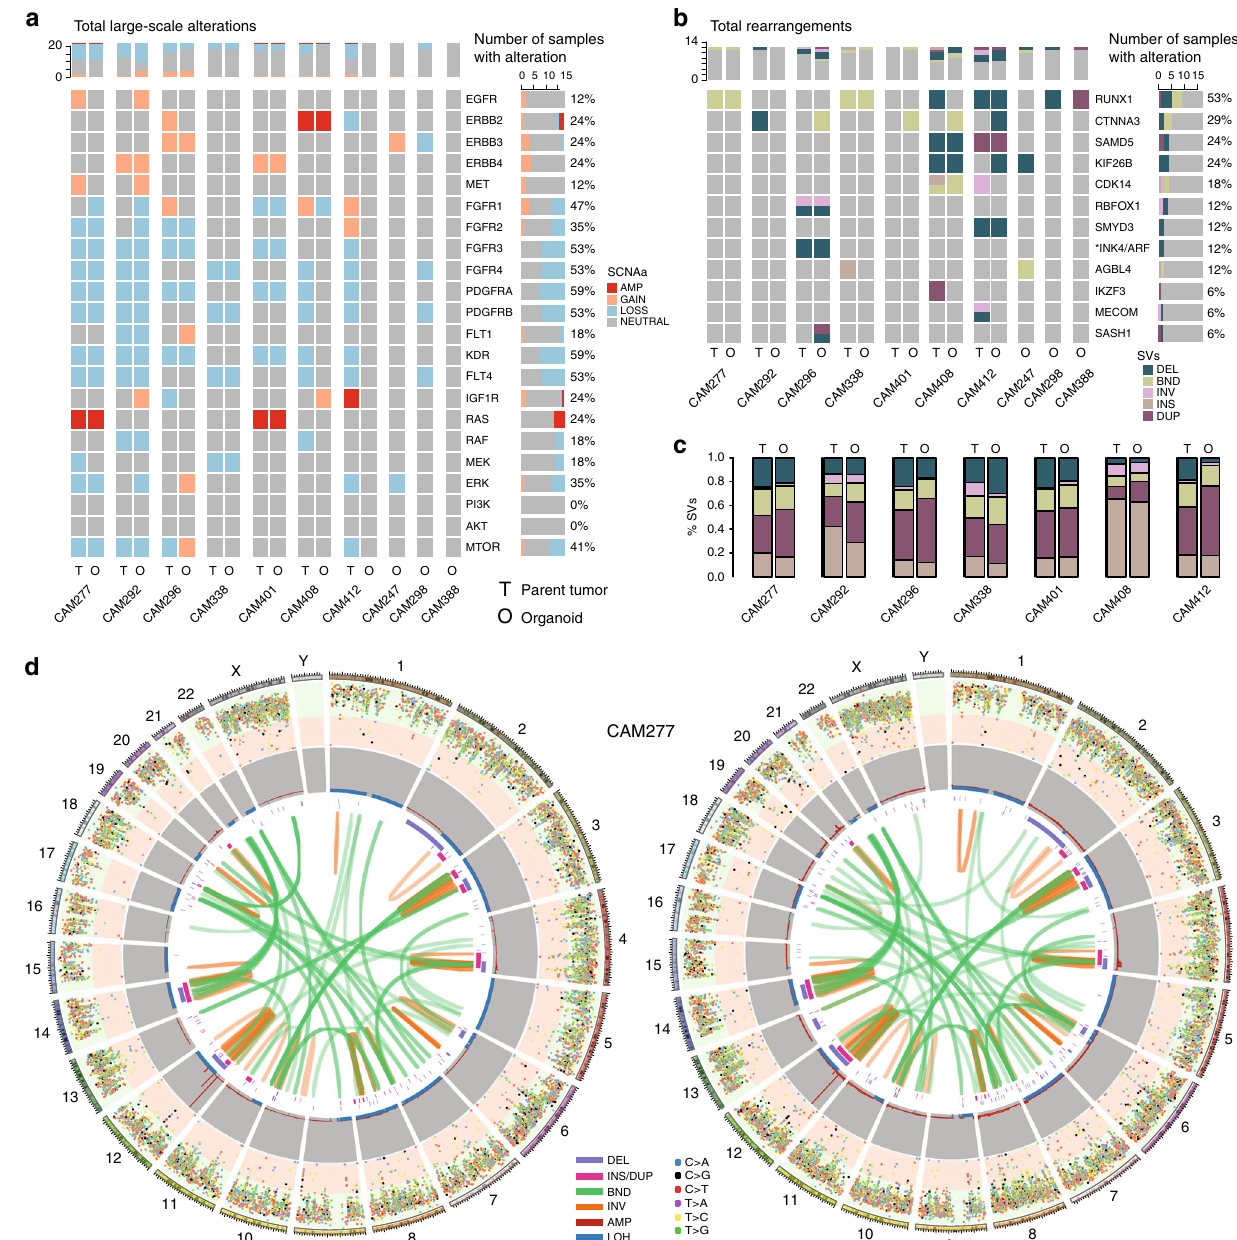
Fig. 3 Organoids have a shared genomic landscape with patient-matched tumors. a Copy number alterations of selected receptor tyrosine kinases and key downstream pathway mediators are highlighted in tumors and corresponding organoids. b Structural variants affecting the top recurrently rearranged genes described in Secrier & Li et al. 13 and c Structural variants are compared between tumor and organoid. d Circos plots depicting all mutations (plotted based on inter-mutational distance), copy number changes, and structural variants in the genomes of tumor CAM277 and matched